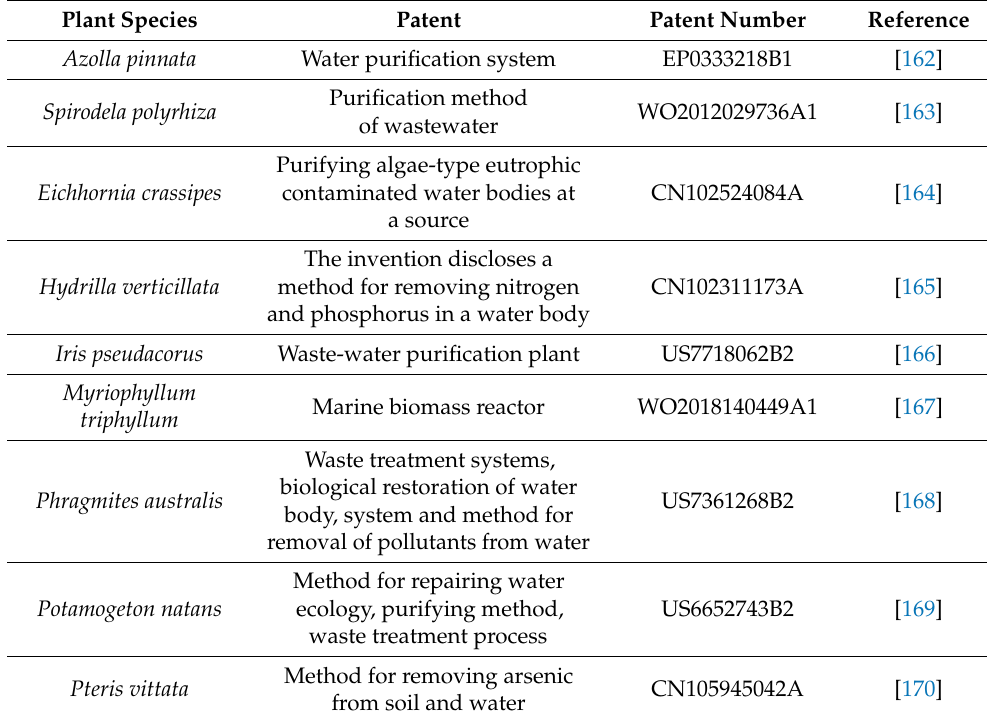
Table 3. Nine species associated with the patents in phytoremediation processes or